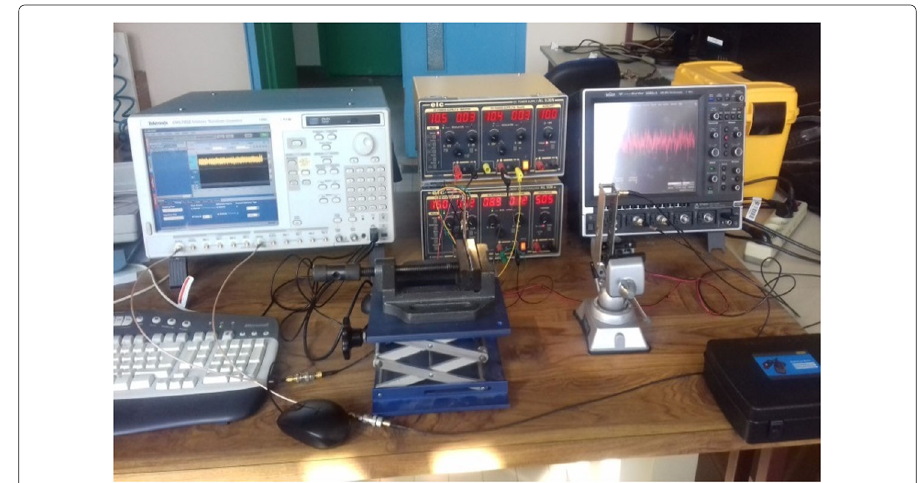
Fig. 5 Photograph of the experimental